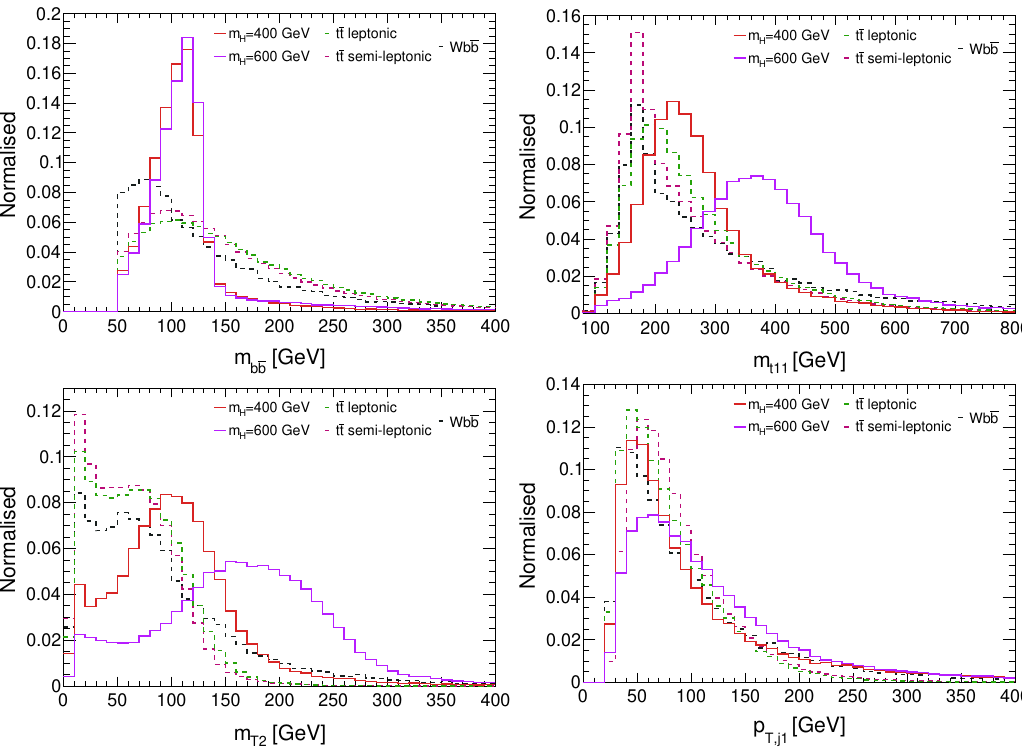
Figure 21 . The m bb , m t 11 , m T 2 and p T;j distributions for the 1 ‘ category for m H = 400 and 1 600 GeV with dominant backgrounds. Here the heavy Higgs boson is searched for in the b (cid:22) bWW (cid:3) channel. The distributions are shown before the multivariate